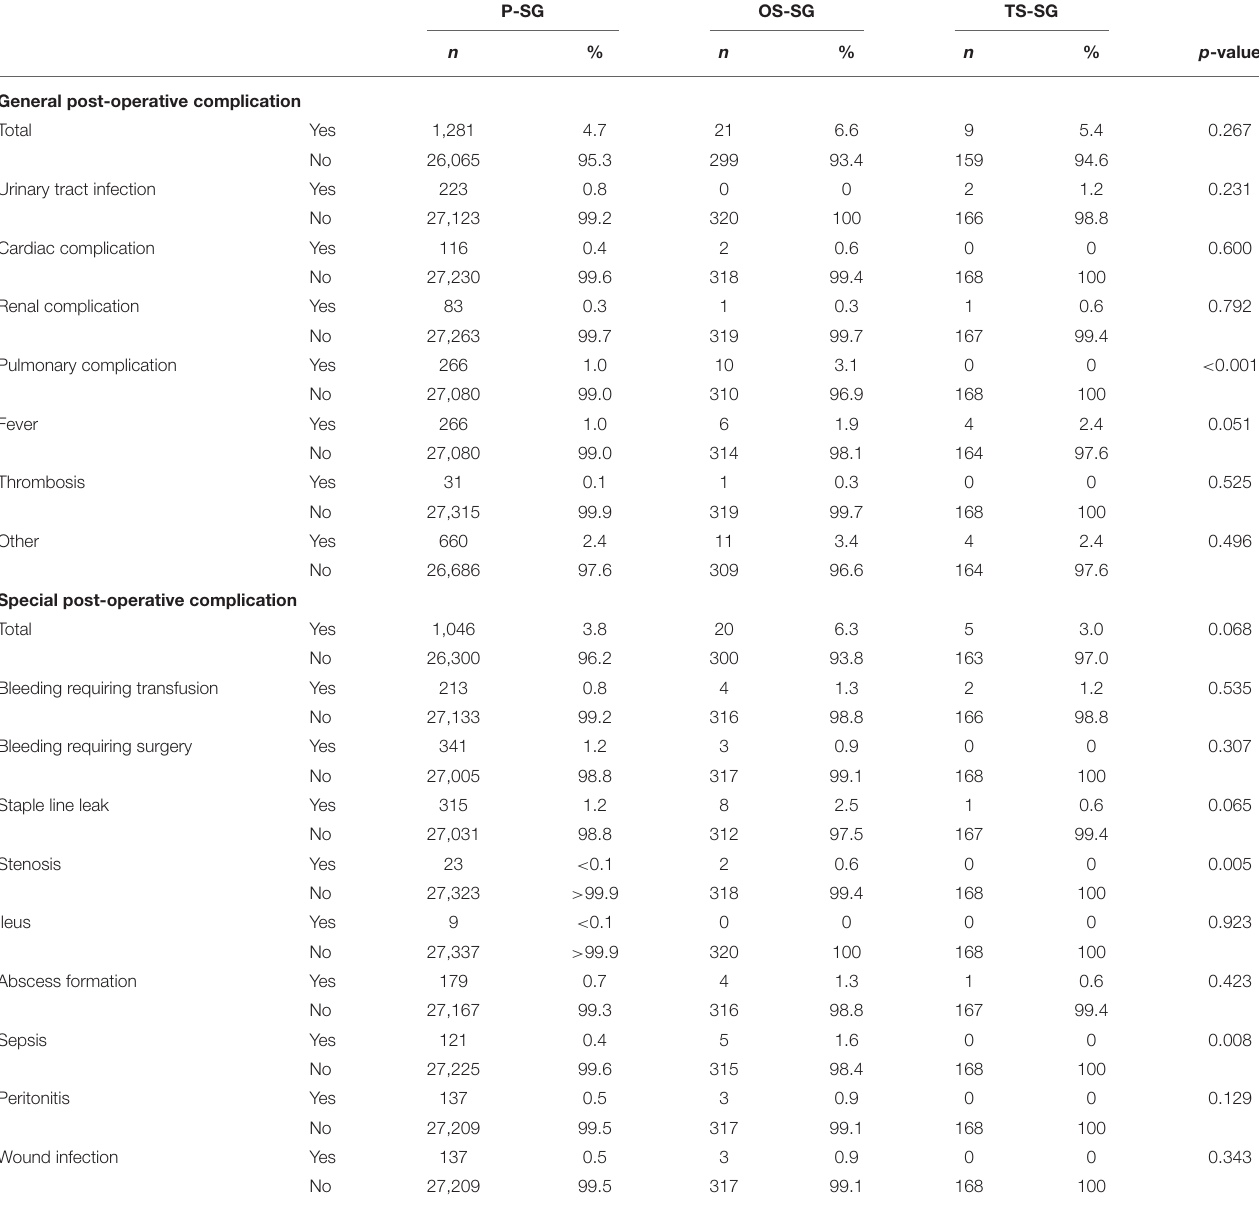
TABLE 5 | General and special post-operative complications.